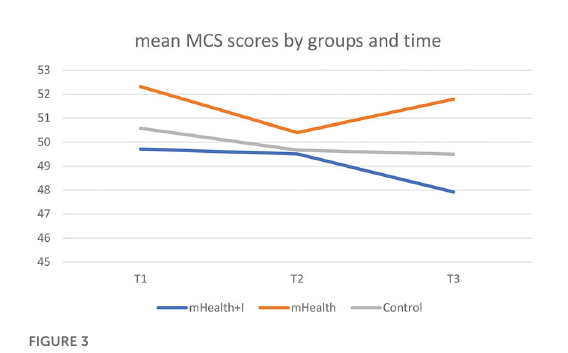
FIGURE3 Mean MCS scores by three groups and